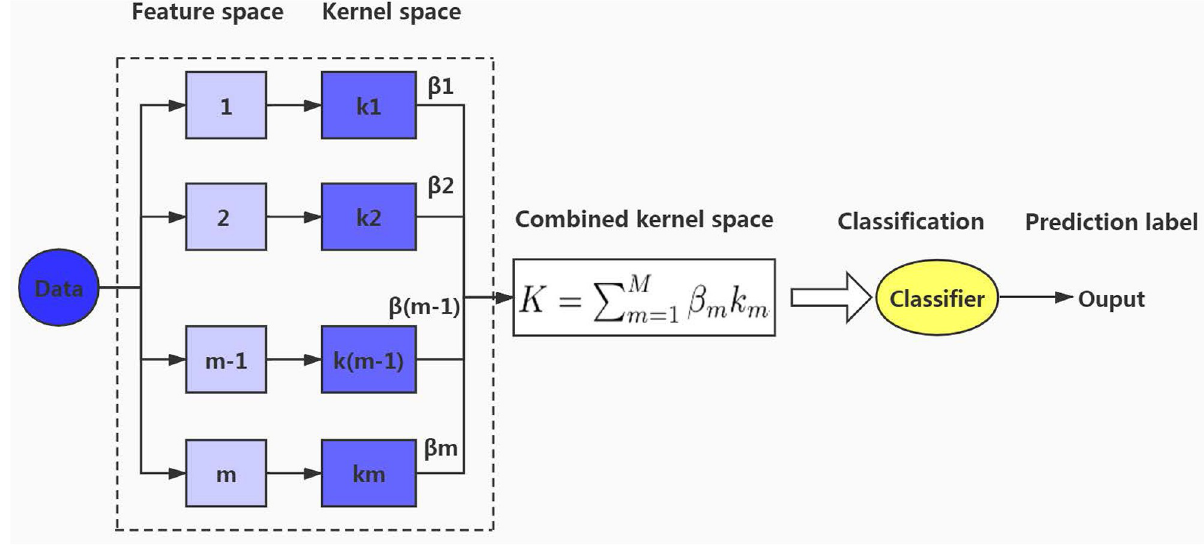
Fig 2. Multiple kernel